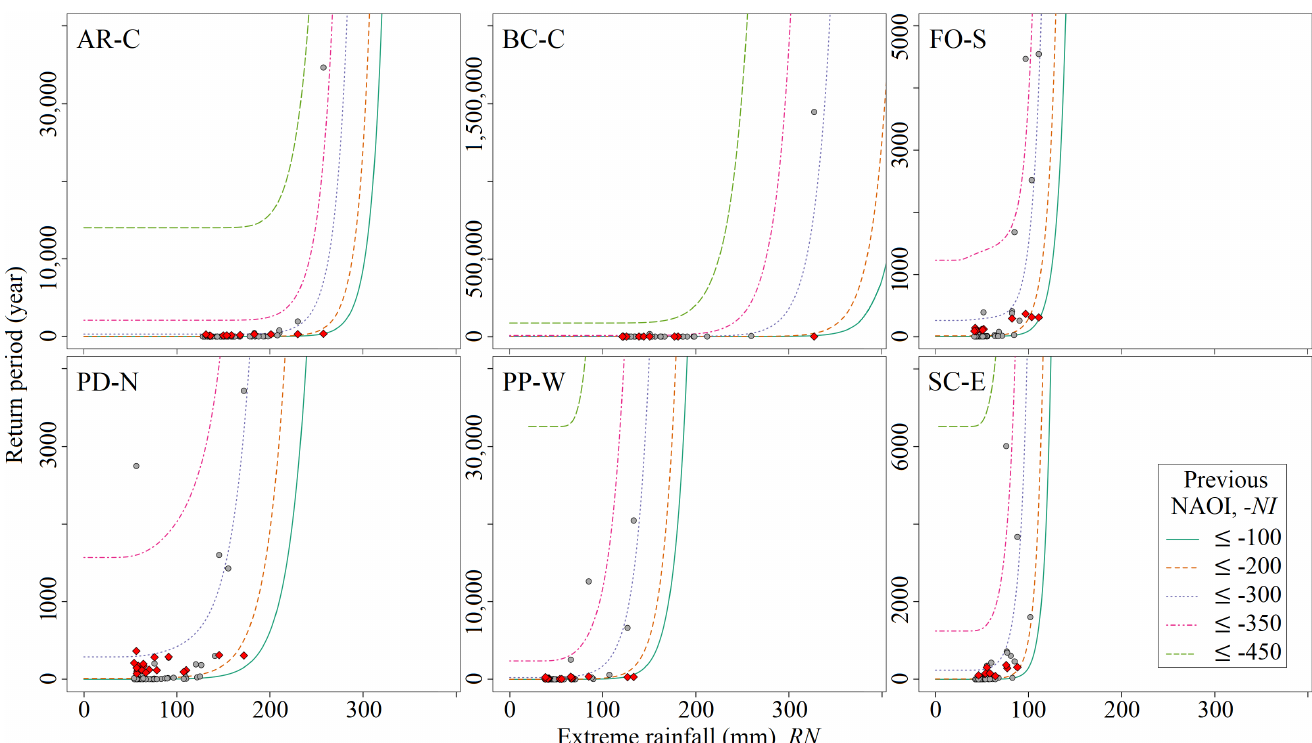
Figure 7. Conditional return periods T RN | NI ≥ ni for different previous NAOI values. The bivariate observations from 1967/1968 to 1999/2000 are depicted by grey bullets, and from 2000/2001 and 2016/2017 by red